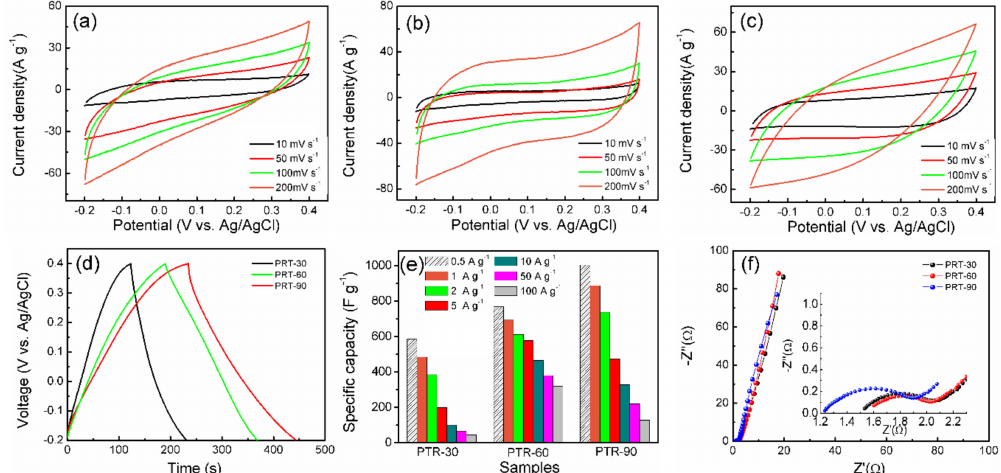
Figure 6. CV curves of ( a ) PRT-30, ( b ) PRT-60 and ( c ) PRT-90 electrodes at scan rates varying from 10 to 200 mV s − 1 ; ( d ) GCD curves of the three kinds of samples; ( e ) histogram of the specific capacity for the three kinds of samples at different current densities; ( f ) Nyquist plots of the samples (the inset is the expanded view of the high-frequency